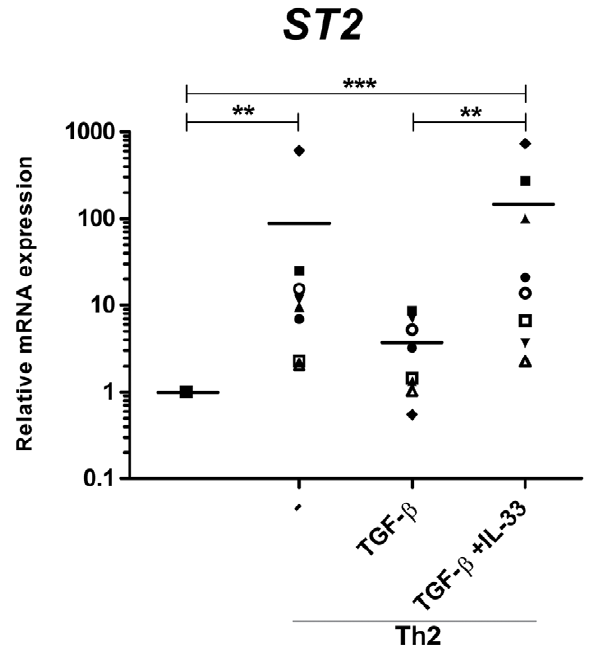
Figure 4. Induction of the IL-33 receptor ST2 by IL-4 and IL-33. Naı¨ve CD4 + T cells were activated with fibroblast-bound anti-CD3/CD28 for 5 days in presence of either blocking antibodies against IFN- c and IL-12 (Th0) or these antibodies plus IL-4 (Th2). At day 5, these cultures were restimulated and split in cultures with and without TGF- b and/or IL-33 for an additional 5 days of stimulation. qRT-PCR gene expression analysis of the relative ST2 expression at day 10 to the Th0 culture. Each donor is represented by a specific symbol and connected with a line. Data are from four independent experiments, each with two donors. Horizontal lines represent means. ** p , 0.01, *** p ,